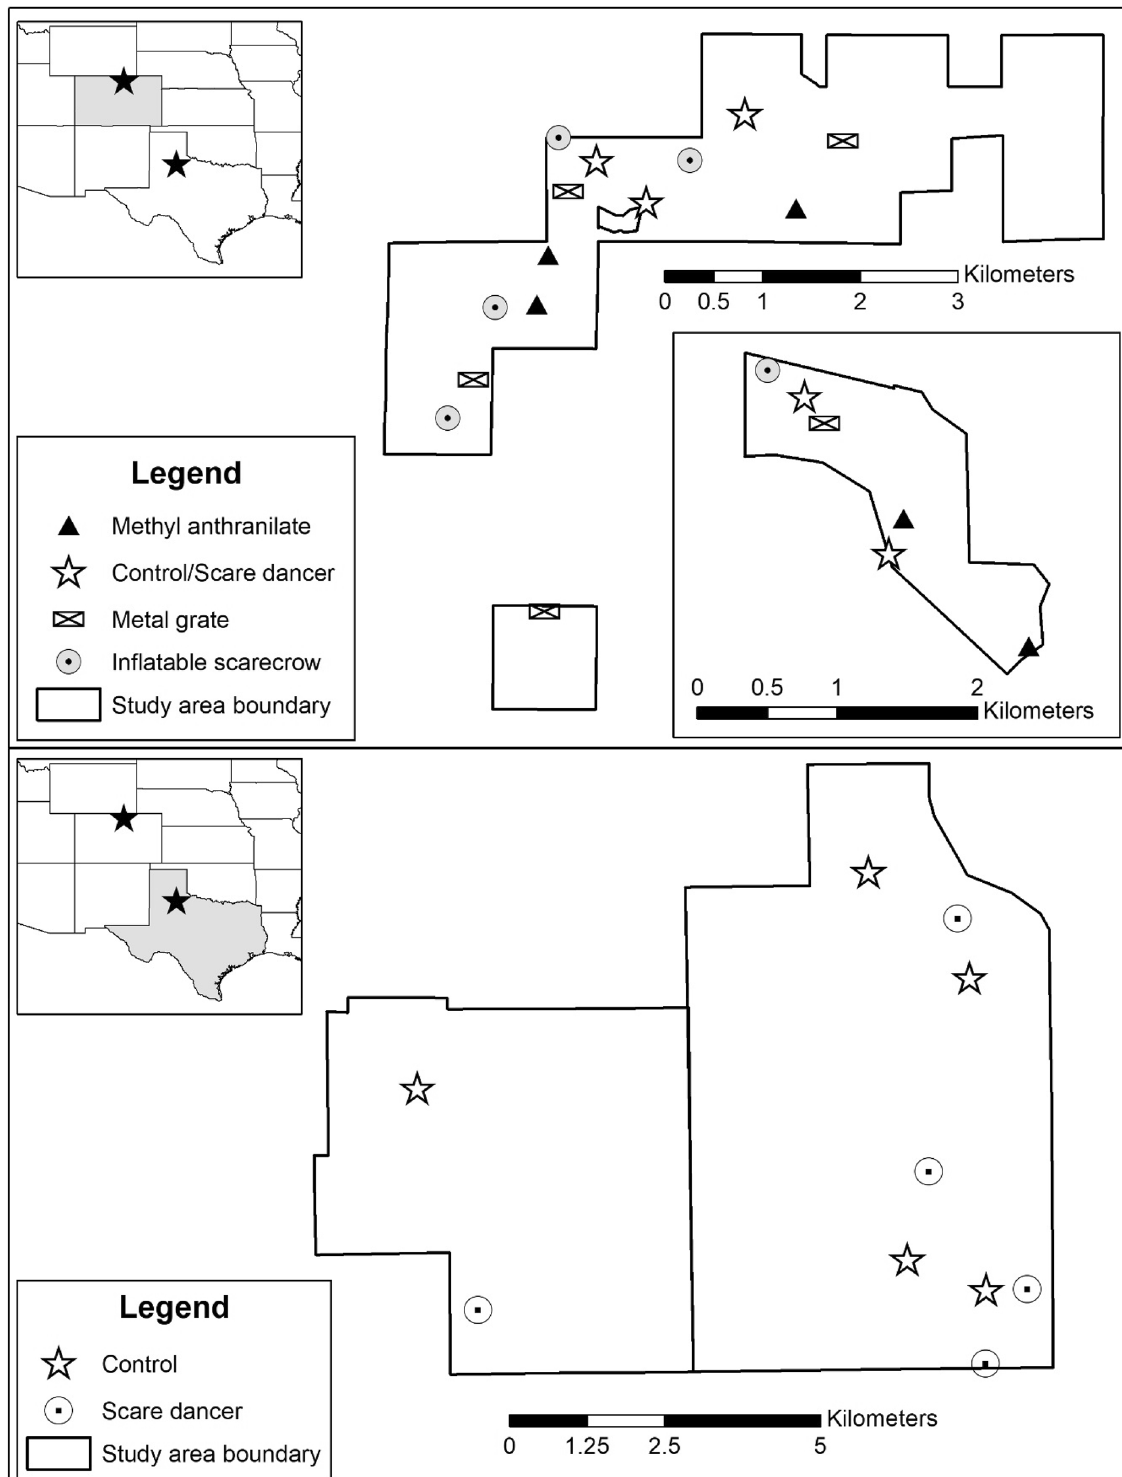
Figure 1. Study areas for evaluating effectiveness of bird deterrents in north-central Colorado, USA during April–May 2020 (top), and for evaluating for reduction in non-target hazards at sodium nitrite toxic bait sites in north-central Texas, USA during July 2020